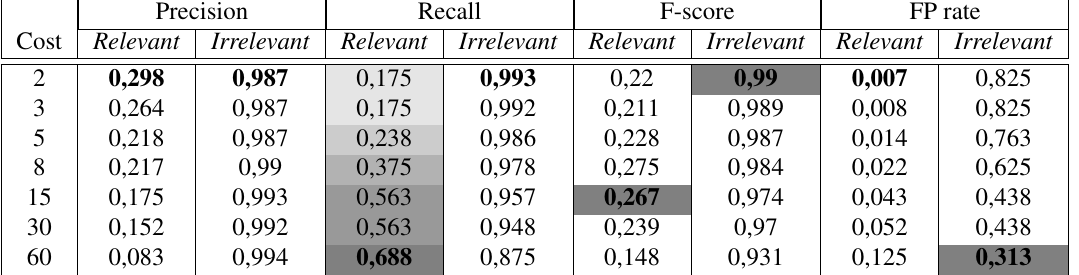
Table 12: Results of a cost-sensitive BN classifier using different cost values for category E. Precision Recall F-score FP rate Cost Relevant Irrelevant Relevant Irrelevant Relevant Irrelevant Relevant Irrelevant